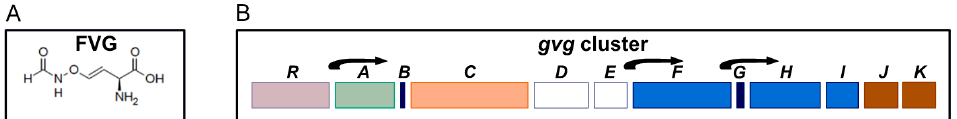
Figure 1. Structure of FVG and the gvg cluster. ( A ) Chemical structure of 4-formylaminooxyvinylglycine (FVG). ( B ) The organization of genes and promoters in the gvg cluster. The genes encode a putative regulator (light purple), proteins of unknown function (green, orange and dark purple), biosynthetic genes (blue), and transporters (brown). Arrows show approximate site of promoters.